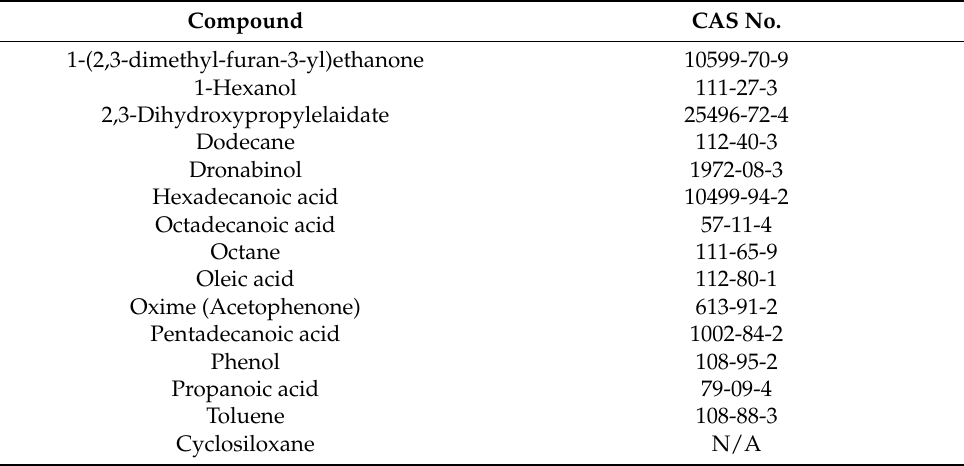
Table 1. VOCs were identified from the contamination test of the SPME fiber and the GC-MS col- umn itself, as well as the blank samples. The compound is identified with a CAS number (CAS no.) from the National Institute of Standards and Technology (NIST) library. However, a CAS no. was not available (N/A) for the various types of cyclosiloxane.